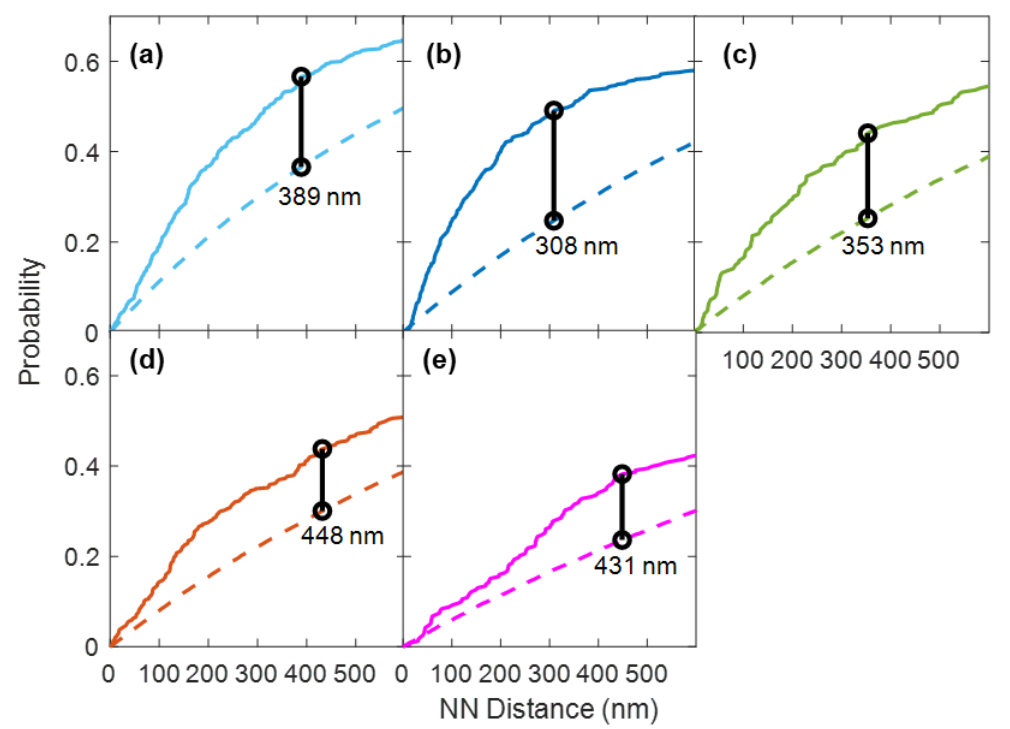
Figure 7. Cumulative distribution functions (CDFs) of the nearest-neighbor distance between ( a ) FLS2 and remorin, ( b ) P2K1 and remorin, ( c ) CERK1 and remorin, ( d ) FLS2 and P2K1, and ( e ) FLS2 and CERK1. Solid line indicates experimental CDFs. Dashed lines indicate simulated CDFs. Black lines indicate the x-values where the maximum difference between experiment and simulation is found.